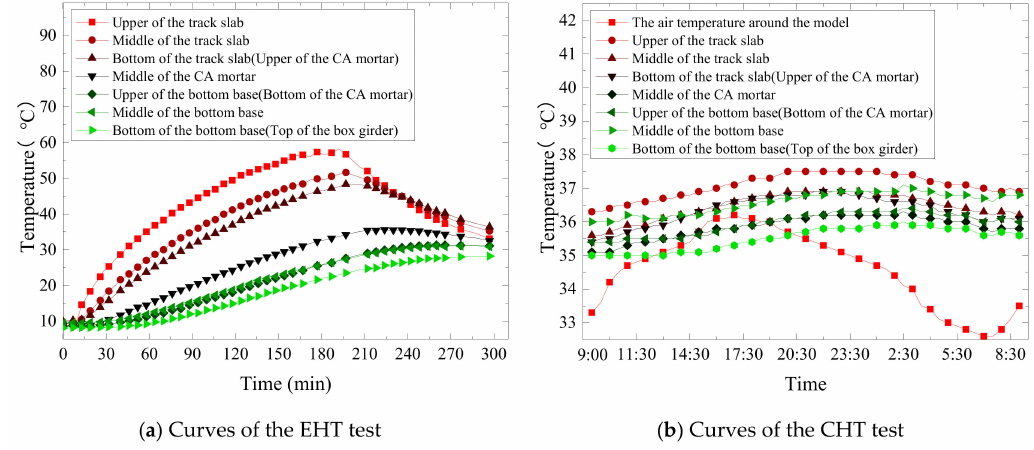
Figure 3. Vertical temperature-time